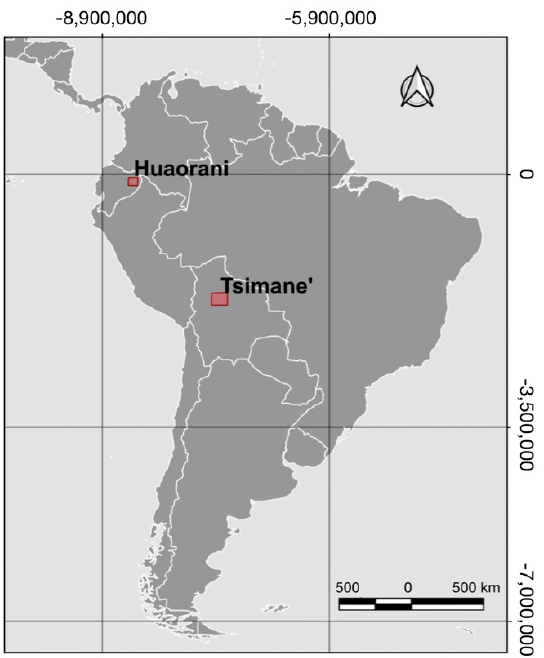
Figure 2. Territory of the Tsimane’ (Bolivia) and the Huaorani (Ecuador).